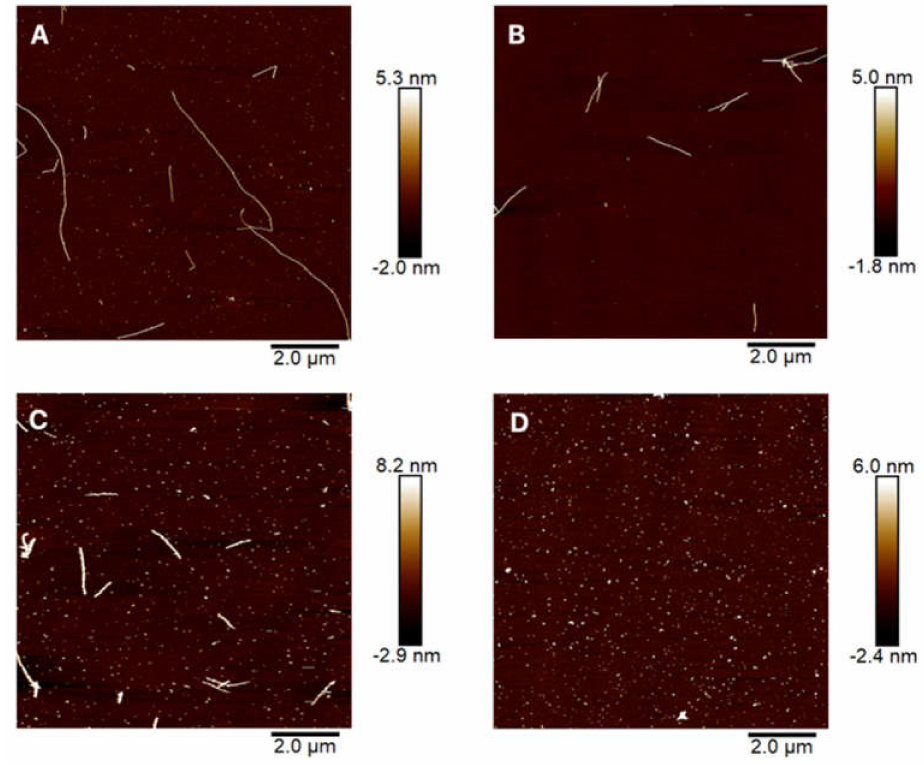
Figure 4. Atomic force microscopy images of Sup35NM amyloid fibrils before ( A ) and after exposure to a pulsed electric field (PEF) using different parameters: ( B ) 10 kV/cm, 50 µ s pulse duration, 10 pulses; ( C ) 10 kV/cm, 1000 µ s pulse duration, 10 pulses; ( D ) 20 kV/cm, 1000 µ s pulse duration, 10 pulses. The adjacent color scale indicates the height of the fibrils found in the